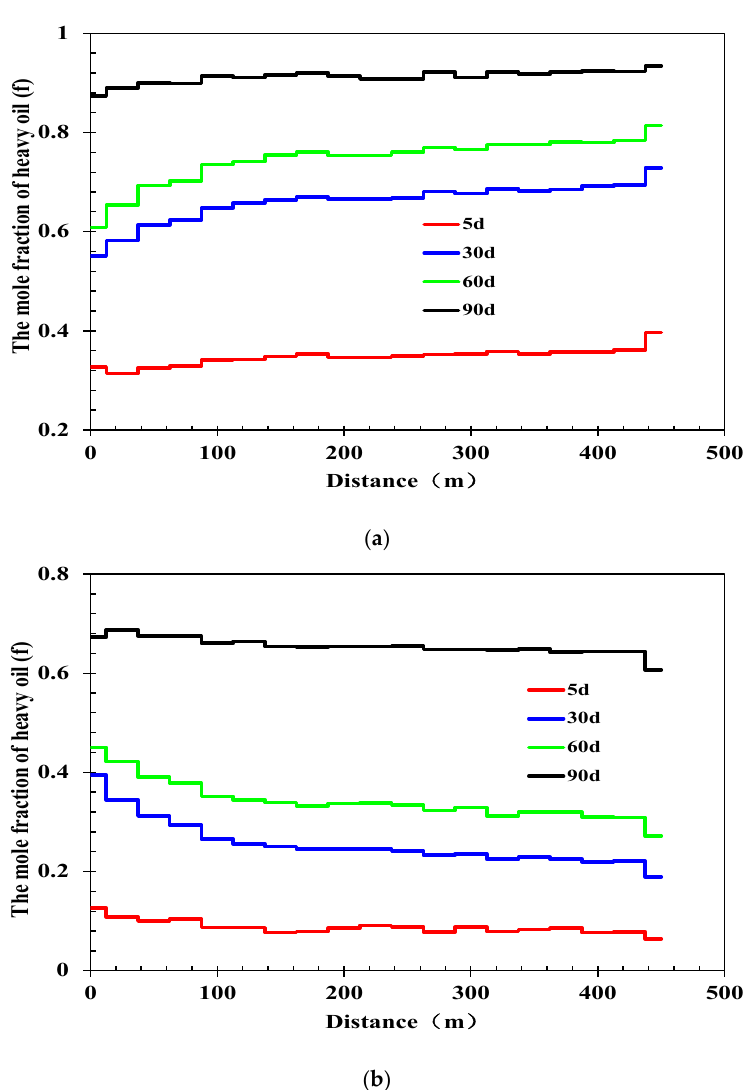
Figure 11. The mole fraction of heat-conduction and super-heavy oil changes with time. ( a ) The mole fraction of heat-conduction oil; ( b ) The mole fraction of heavy oil.